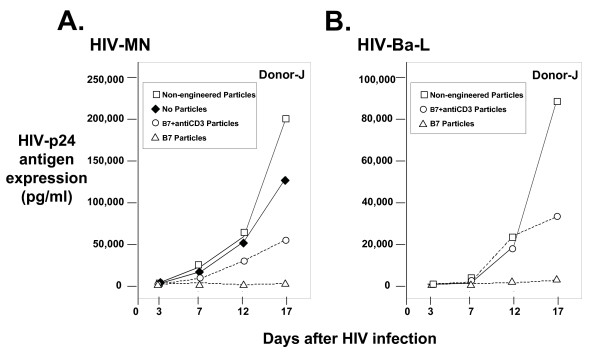
Surface-engineered HIV-based particle dependent inhibition of HIV-1 replication. Panel A: Lymphocytotropic HIV-1 MN p24 antigen expression in PHA-stimulated PBLs. Panel B: Monocytotropic HIV-1 Ba-L p24 antigen expression in PHA-stimulated PBLs. Donor-J cells were PHA-treated and exposed to either no particles (filled diamonds), non-engineered HIV-based particles (open squares), B7+antiCD3 surface-engineered HIV-based particles (open circles), or B7 surface-engineered HIV-based particles (open triangles). At day 3, cultures are washed and infectious HIV-1 is added – HIV-MN in Panel A and HIV-Ba-L in Panel B. Aliquots are removed at 3, 7, 12, and 17 days and HIV-1 encoded p24 antigen expression is determined by ELISA. Particle preparations used in this figure were PEG-concentrated and inactivated to render them non-infectious.